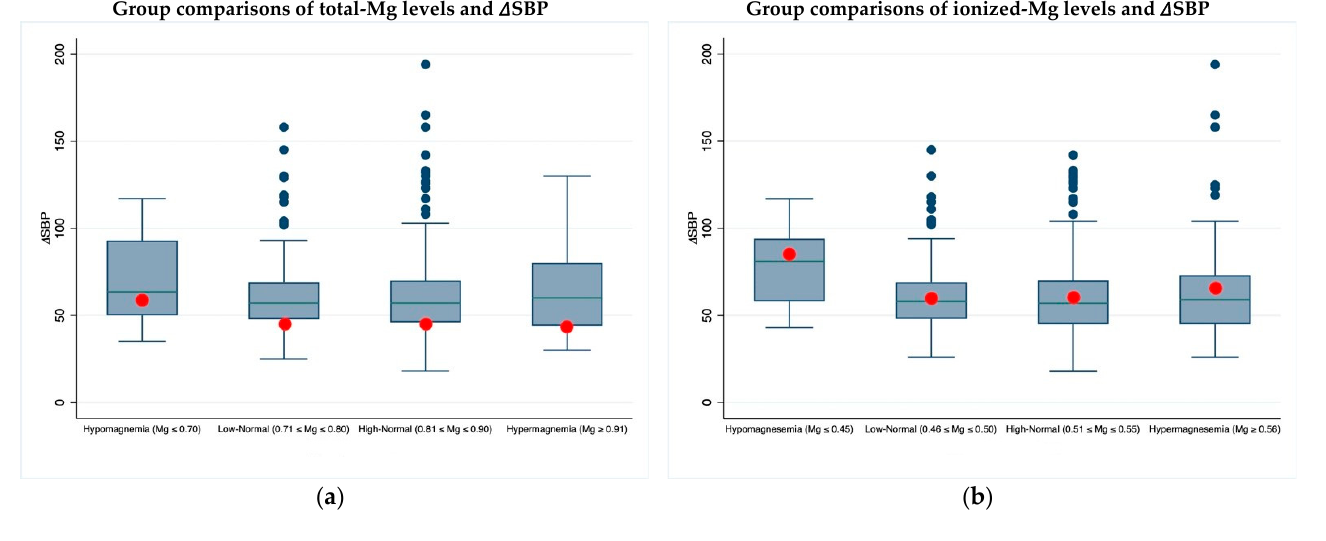
Figure 3. Two-by-two group comparisons of total and ionized magnesium levels and 𝛥 SBP: ( a ) 𝛥 SBP and tot-Mg; ( b ) 𝛥 SBP and ion-Mg. In the box plots, red circles indicate mean values, while blue lines indicate median values.